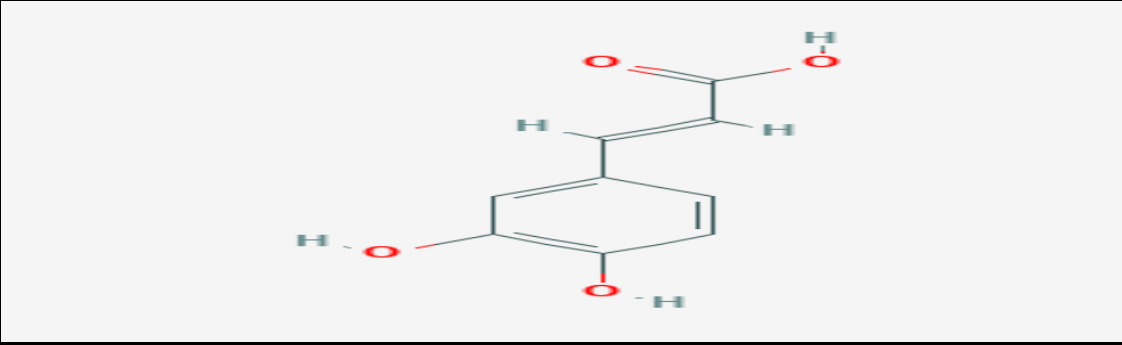
Figure 25. Chemical structure of Caffeic acide with molecular weight 180 Gram/mol